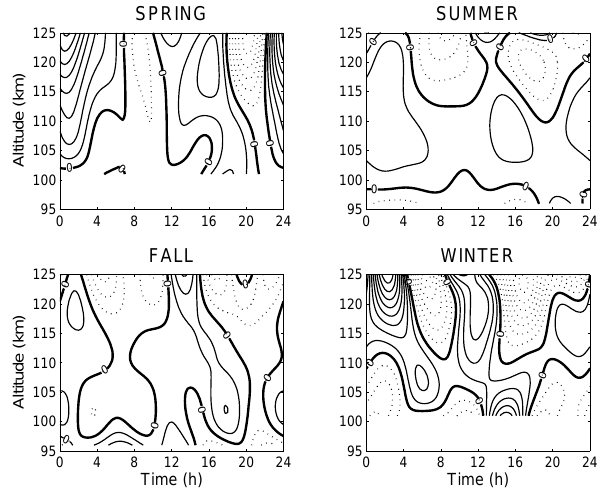
Fig. 4. Vertical velocity field resulting from the action of the wind for spring, summer, fall and winter; the same plot details as in the previous figures.